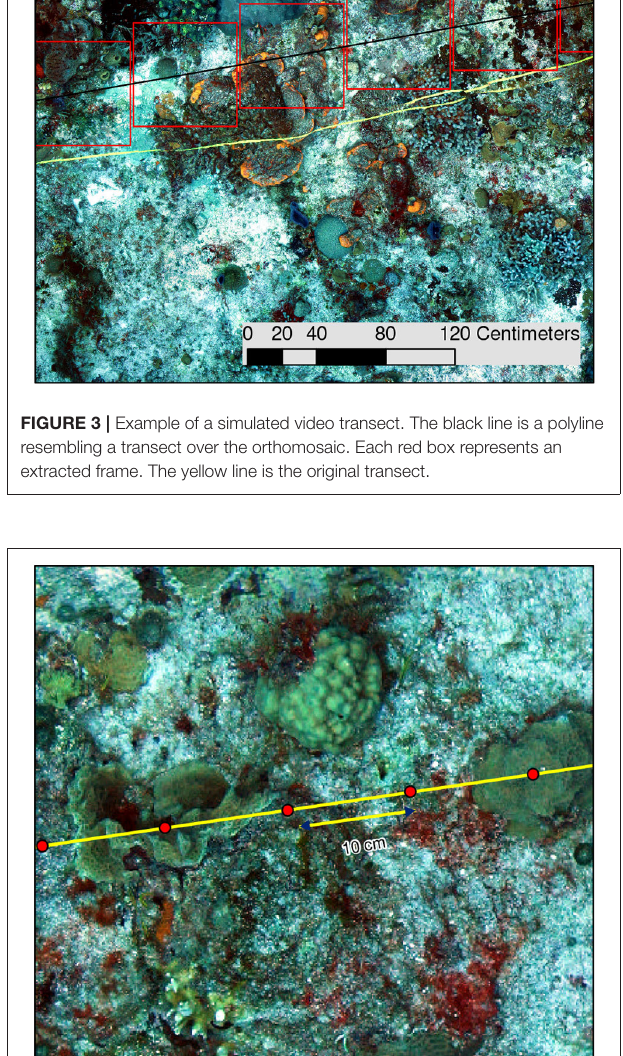
model (Zeileis and Hothorn, 2002; Hothorn et al., 2008; Zuur et al., 2009). The models were validated using standard residual diagnostics. A plot of residuals vs. fitted values was used for the assumption of homoscedasticity, and q-q plots of residuals were used to test the residual normality assumption.